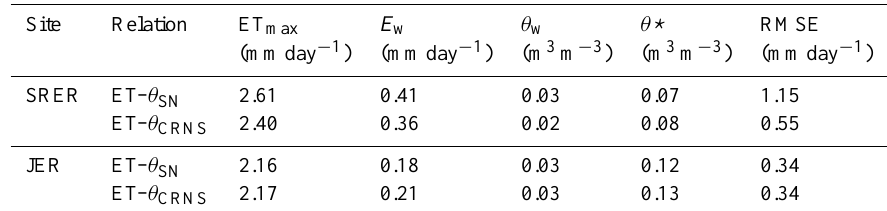
Table 6. Regression parameters for the relations of evapotranspiration and soil moisture ( θ SN and θ CRNS ) at the SRER and JER sites along with the RMSE of the regressions. θ h = 0 in all